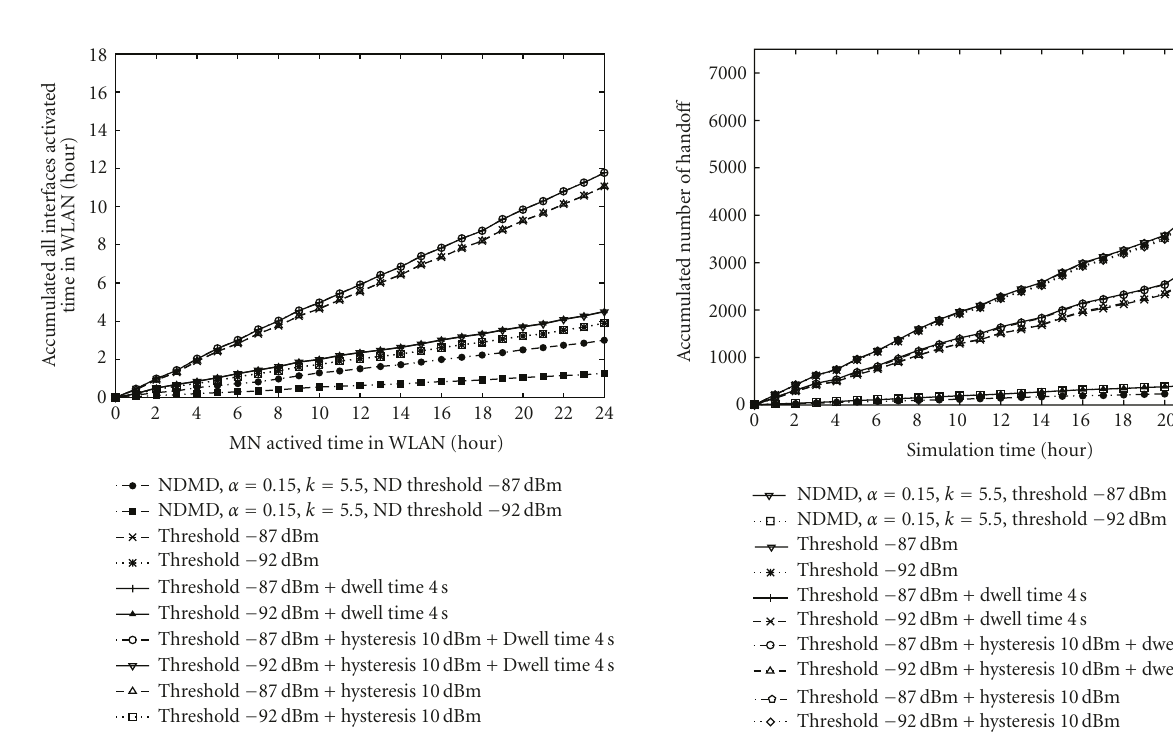
Figure 22: Accumulated active time of all interfaces in WLAN.